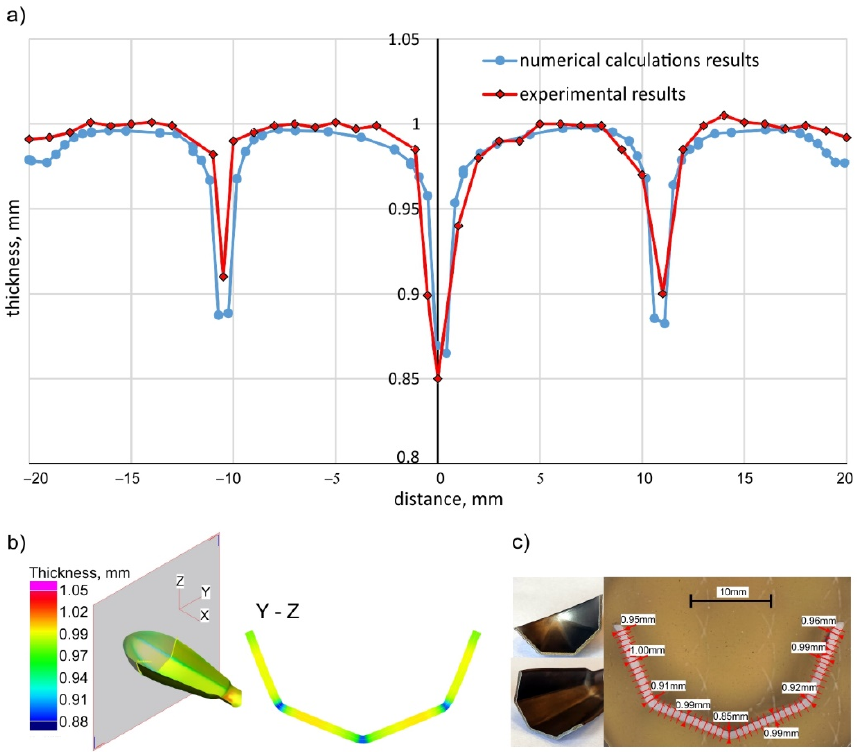
Figure 15. Thickness distribution: ( a ) comparison of experimental and numerical results; ( b ) numerical calculation results; ( c ) experimental verification.